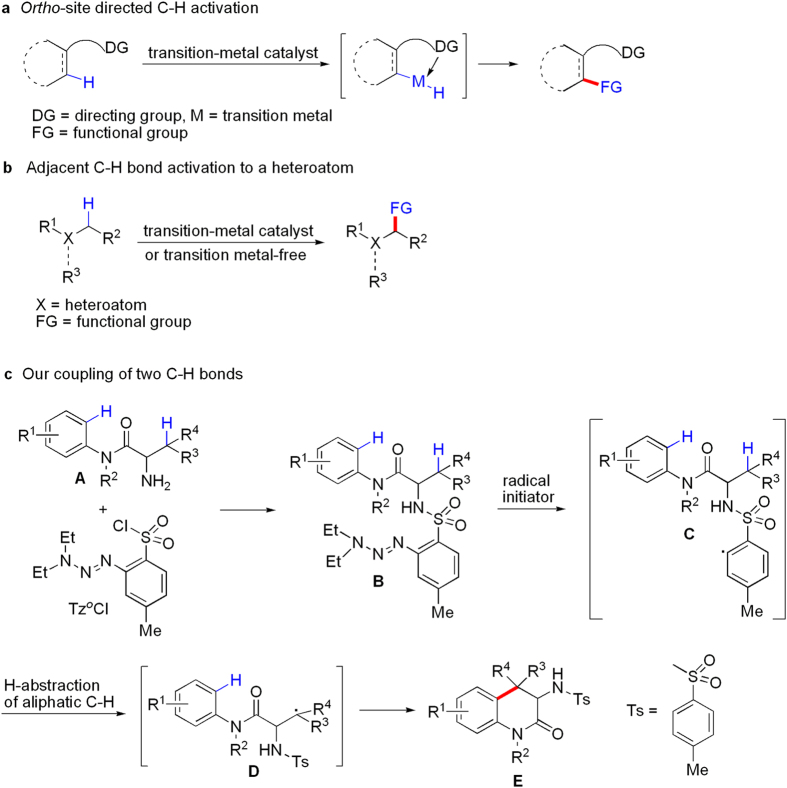
Design on transition metal-free intramolecular coupling of unactivated aliphatic and aromatic C-H bonds.(a) Ortho-site directed C-H activation. (b) Adjacent C-H bond activation to a heteroatom. (c) Description of the concept on our coupling of two C-H bonds.